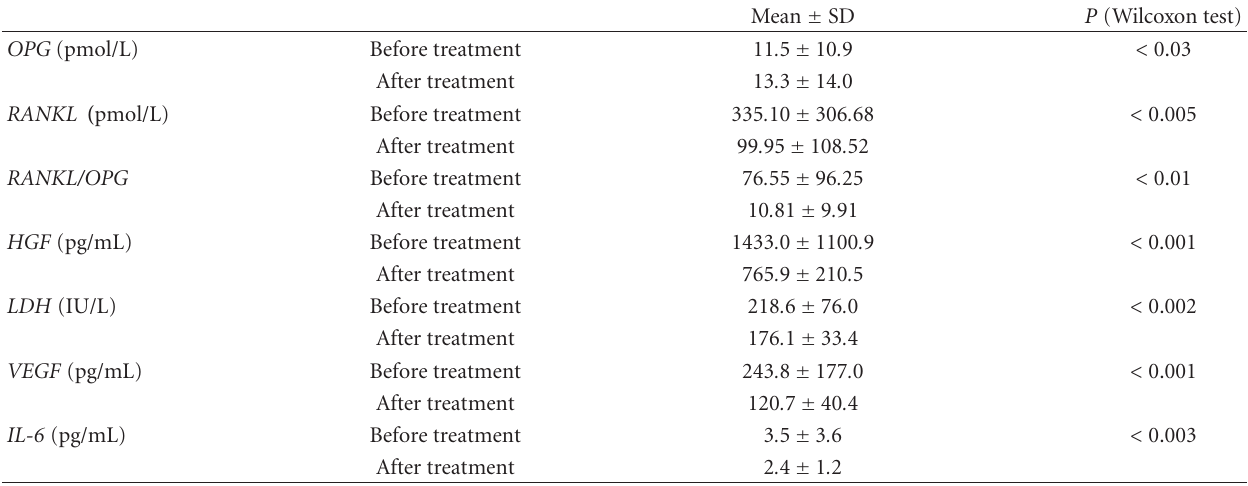
Table 5: Mean ± SD values of the measured parameters in MM patients before and after